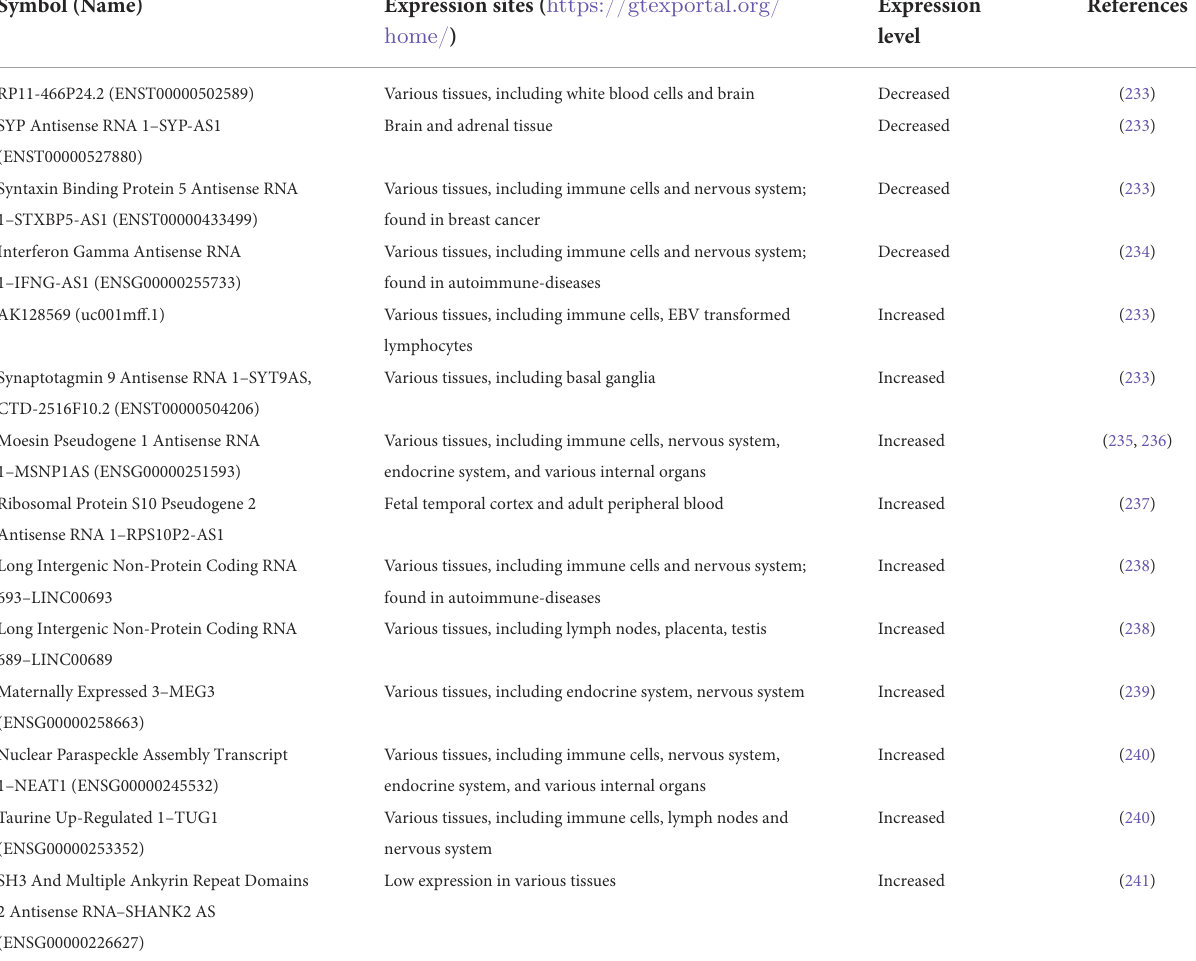
TABLE 3 Non-coding RNAs found altered in